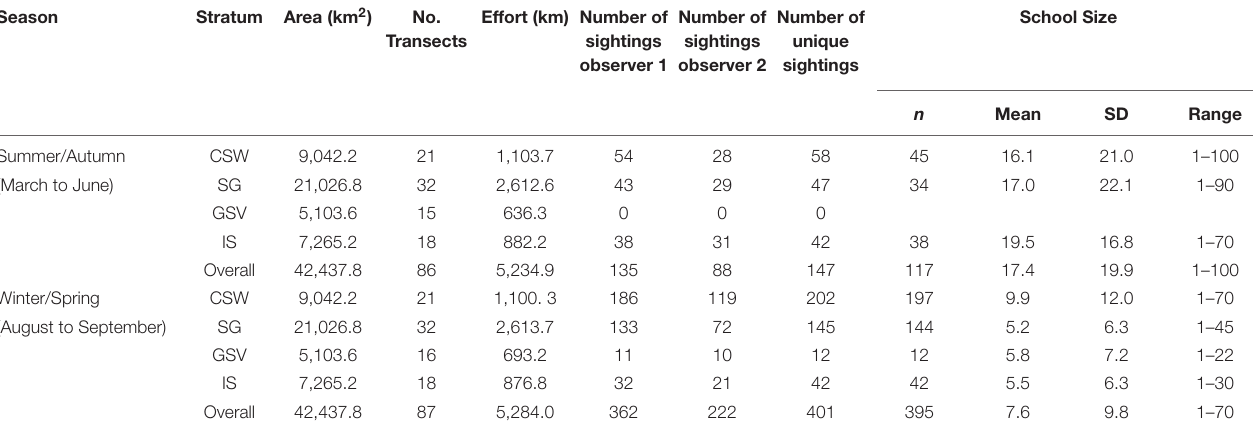
TABLE 2 | Summary of aerial survey effort in 2011 in central South Australia by season and stratum (CSW, Central shelf waters; SG, Spencer Gulf; GSV, Gulf St. Vincent; IS, Investigator Strait), number of common dolphin ( Delphinus delphis ) schools sighted (before truncation) by mid (observer 1) and rear (observer 2) platforms, and estimates of school